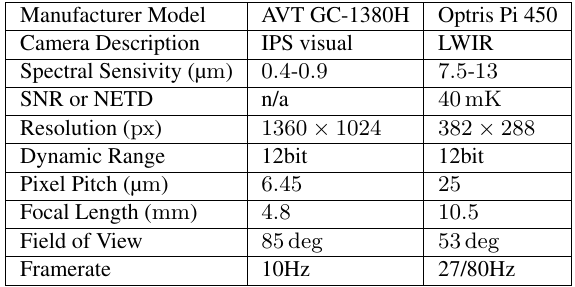
Table 1. Key specifications for the trifocal sensor